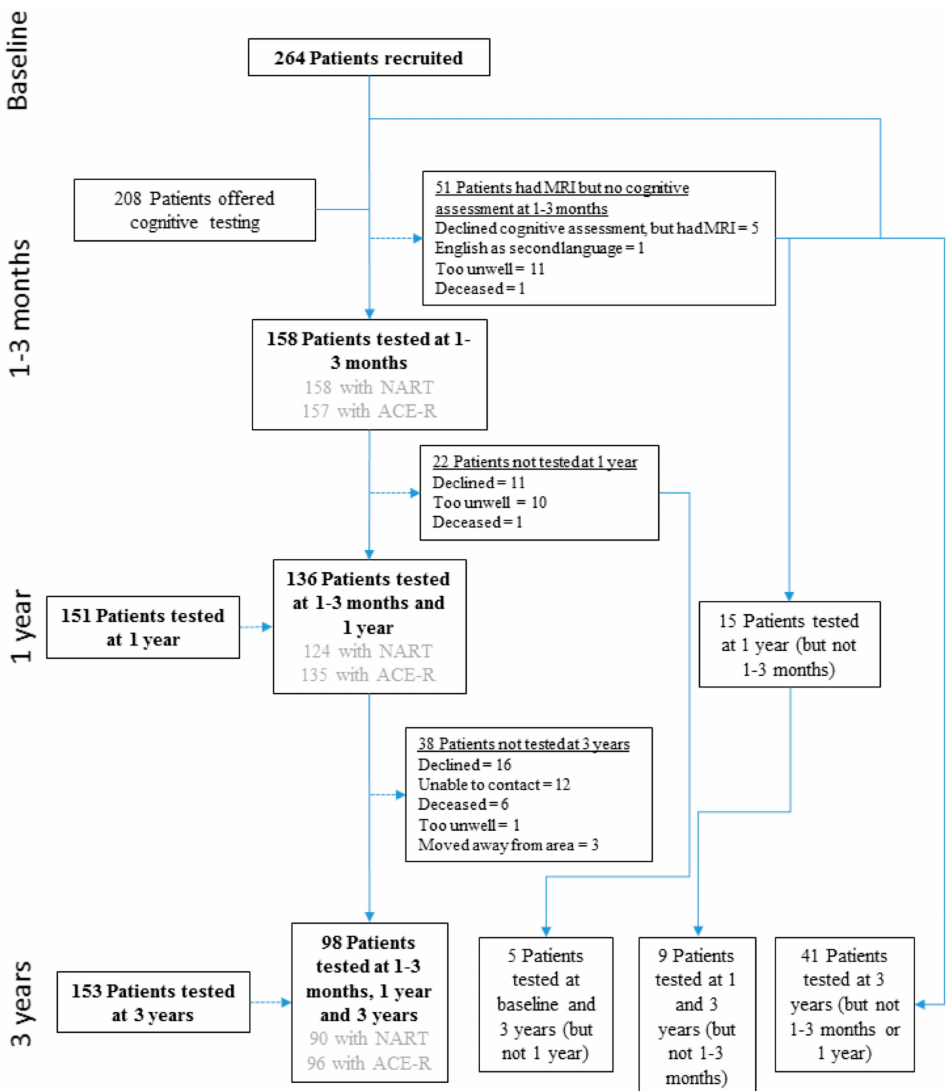
Figure 1. Flow chart showing number of participants with cognitive assessment (estimated premorbid, current, or both) at each time-point in the Mild Stroke Study II